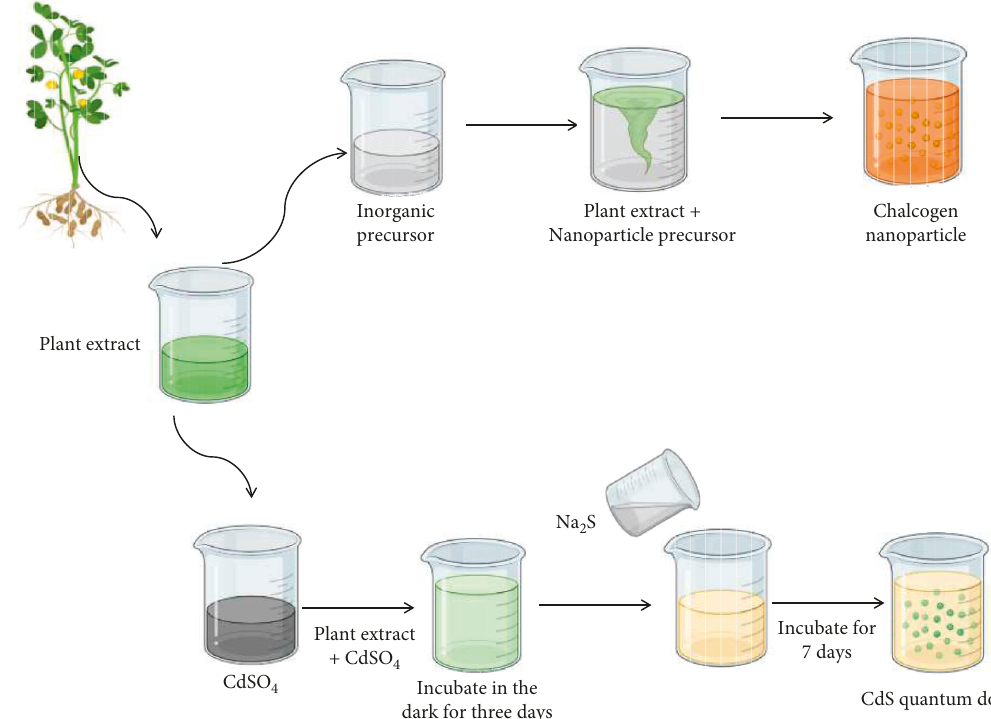
Figure 3: Illustration of the protocol involved in the synthesis of chalcogens and chalcogenide